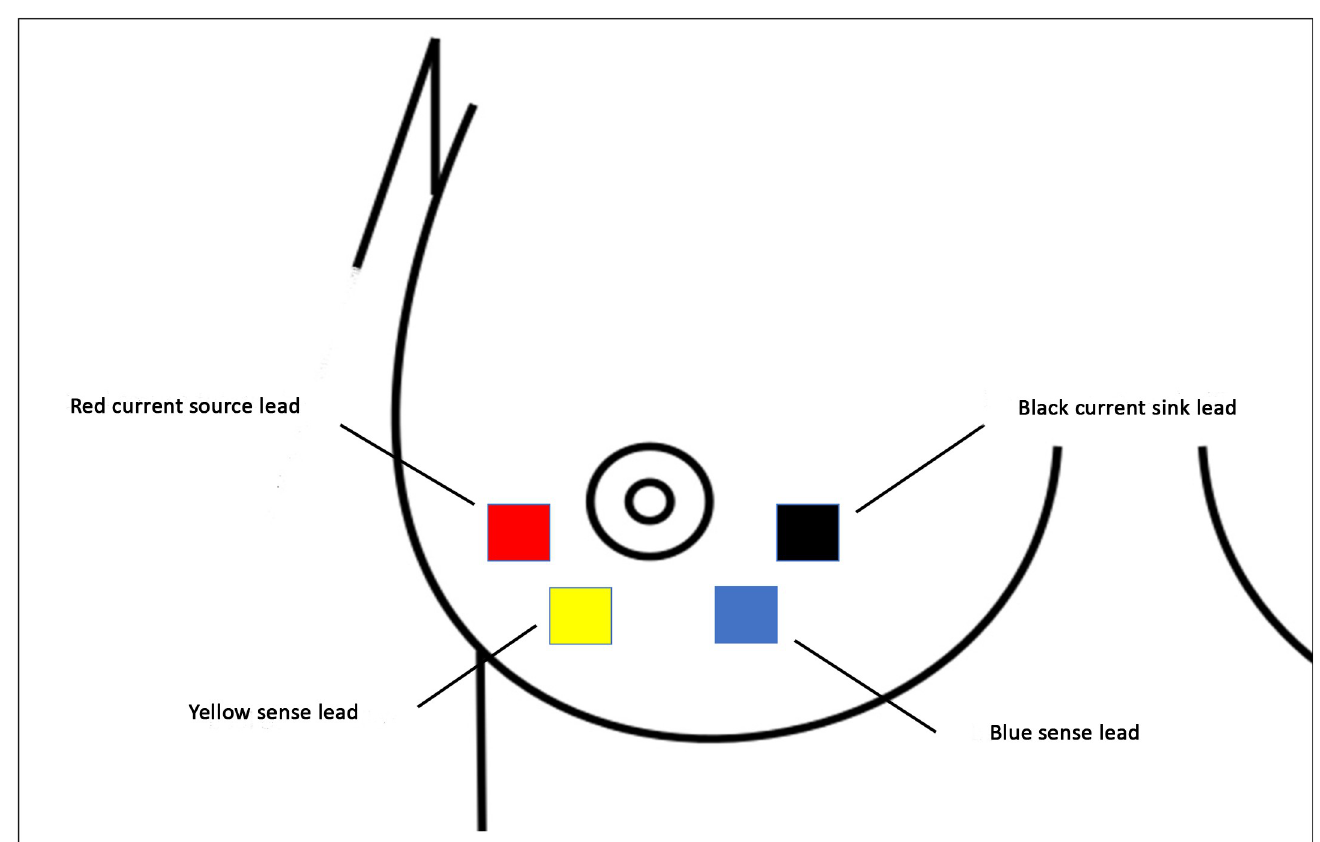
Fig 2. Diagrammatic representation of electrode